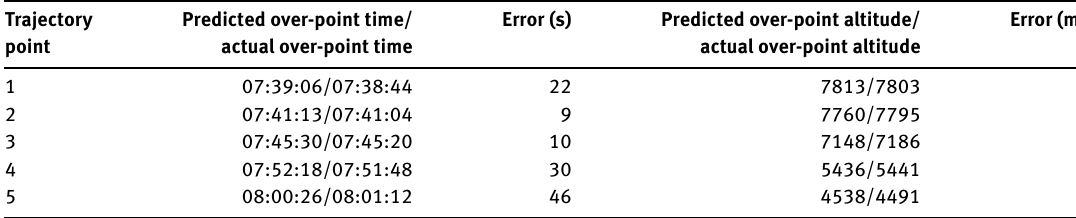
Table 1: Comparison of Trajectory Point Predicted